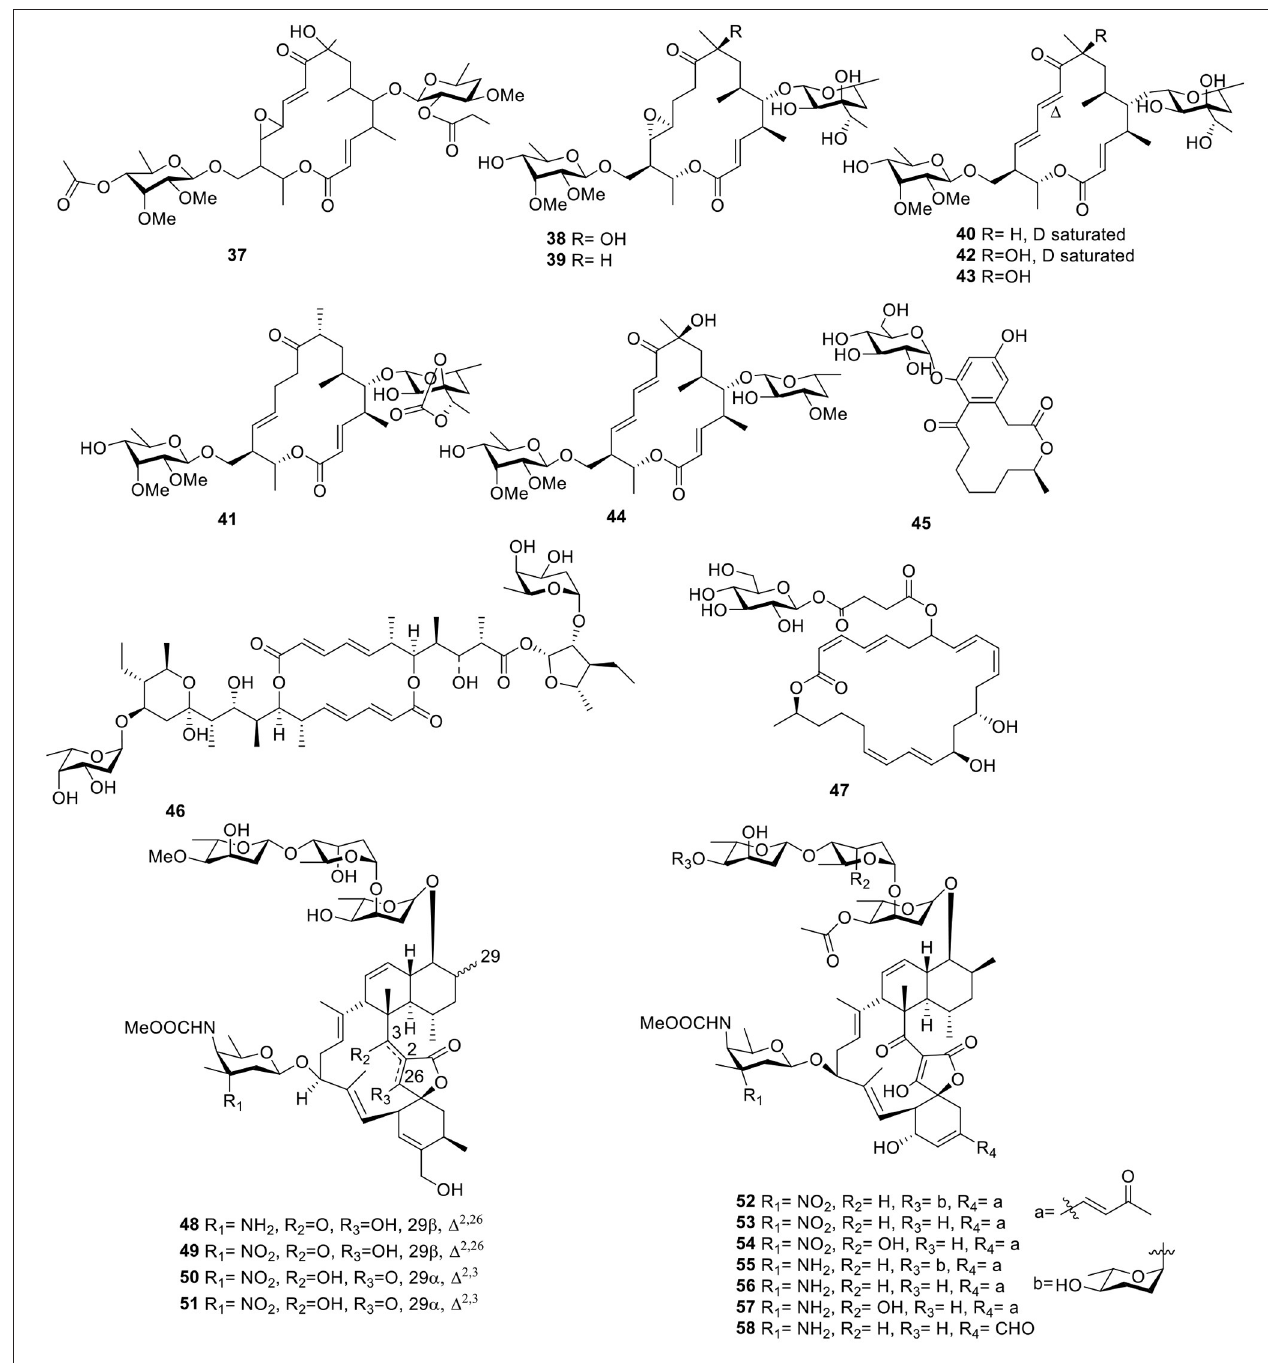
FIGURE 4 | Chemical structures of compounds 37–58 derived from marine-sourced